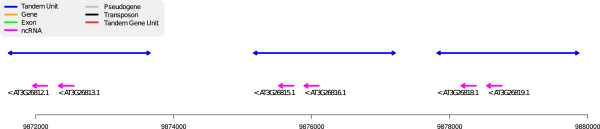
An example of duplicated miRNA genes. Region 9,872,000-9,880,000 of chromosome 3. A pure non coding TA where each TU (in blue) covers 2 miRNAs (in purple) and an upstream region.